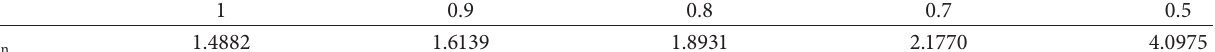
� 1, η � 4 , ζ � 1, d � 1 , σ � 0 . 05 , σ M M M 1